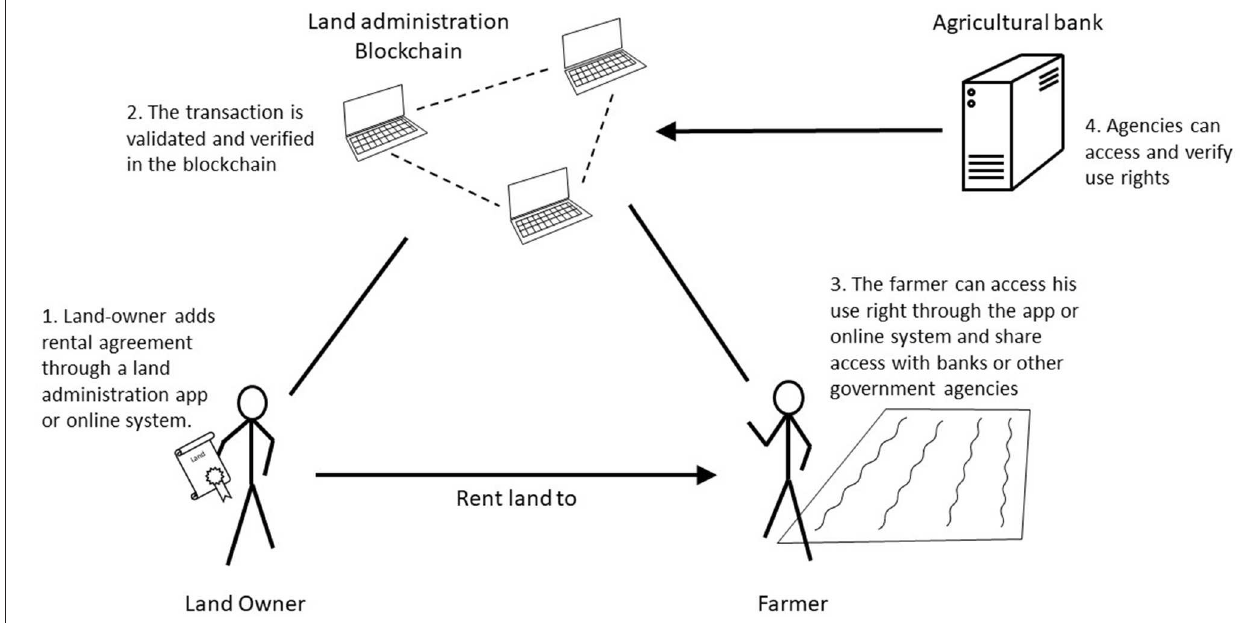
FIGURE 1 | A simple schematization of a blockchain application for the exchange of land use rights within a land rental market.